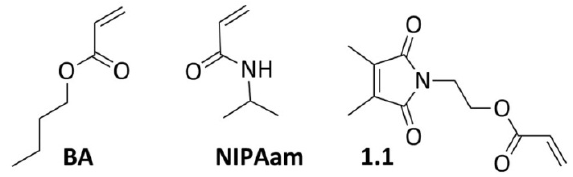
Figure 1. The monomers n -butyl acrylate (BA), N -isopropyl acrylamide (NIPAm) and N -ethylacrylate-3,4-dimethylmaleimide ( 1.1 ).